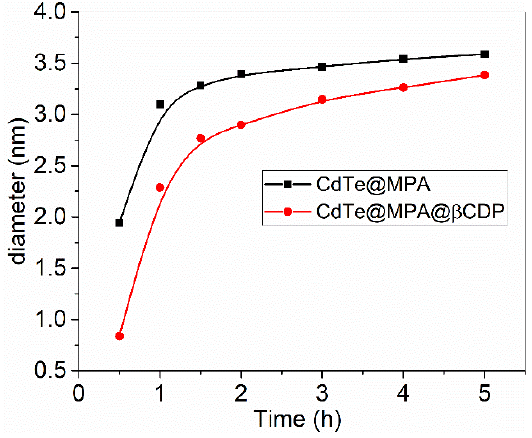
Figure 2. Size-dependence of CdTe QDs prepared in the absence and presence of βCDP.